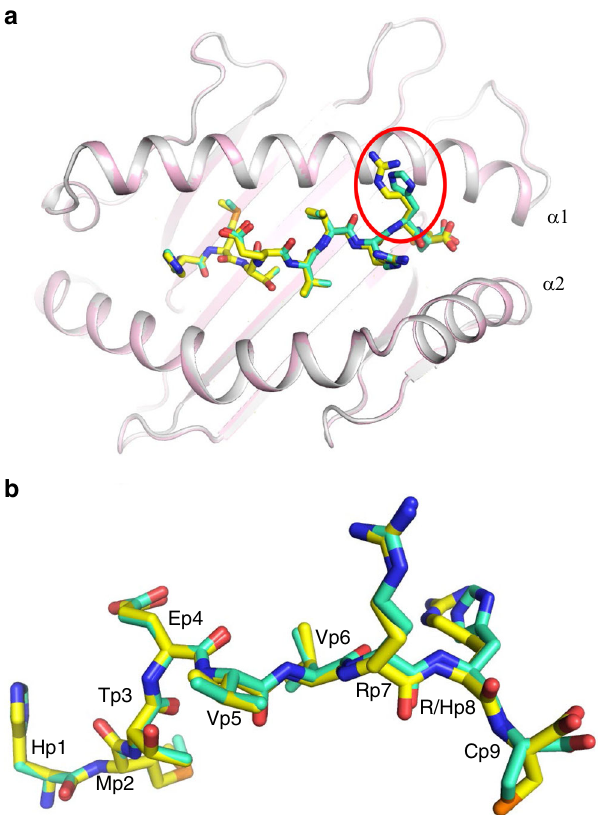
Fig. 2 Conformation of wild-type and mutant p53 peptides bound to HLA- A2. a Top view of superposed p53 – HLA-A2 and p53R175H – HLA-A2 complexes. Wild-type and mutant p53 peptides are yellow and green, respectively. The P8 mutation site is circled. HLA-A2 is gray (p53 – HLA-A2) or light pink (p53R175H – HLA-A2). b Side view of superposed wild-type and mutant p53 peptides. Residue labels are aligned with the α -carbon atom of the respective residue. Carbon atoms are yellow (p53) or green (p53R175H); nitrogen atoms are blue; oxygen atoms are red; sulfur atoms are